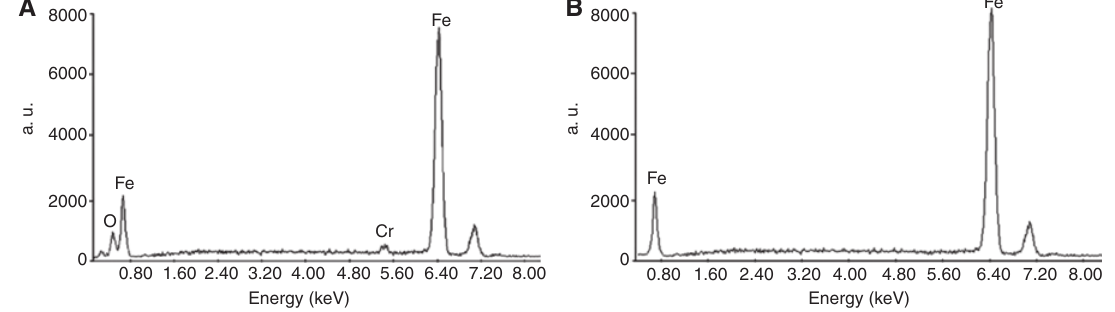
Figure 6: EDS spectra of (A) FeOOH precipitated from the leaching solution and (B) FeOOH after the oxidation of Cr.